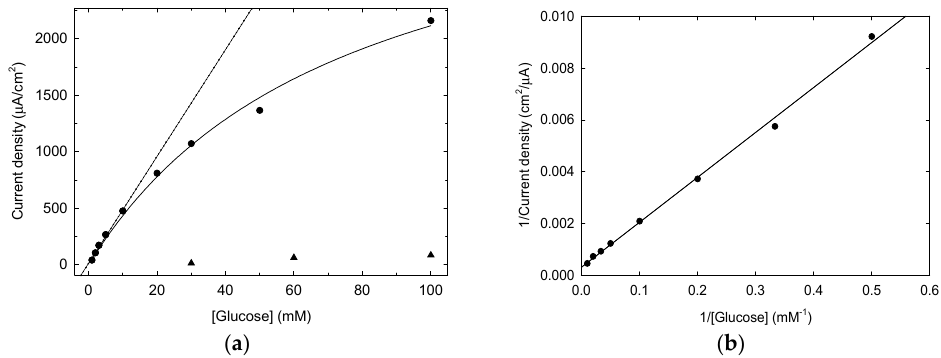
Figure 8. Panel ( a ): calibration curves for glucose detection on untreated Pt (triangles) and on phosphate buffer 0.1 M LIFT treated Pt (circles), the straight line interpolates the first 5 points (linear response) while the curved line (Langmuir model of Equation (2)) interpolates the data in the whole concentration range tested. Panel ( b ): double reciprocal plot of the calibration curve derived from data in panel ( a ).